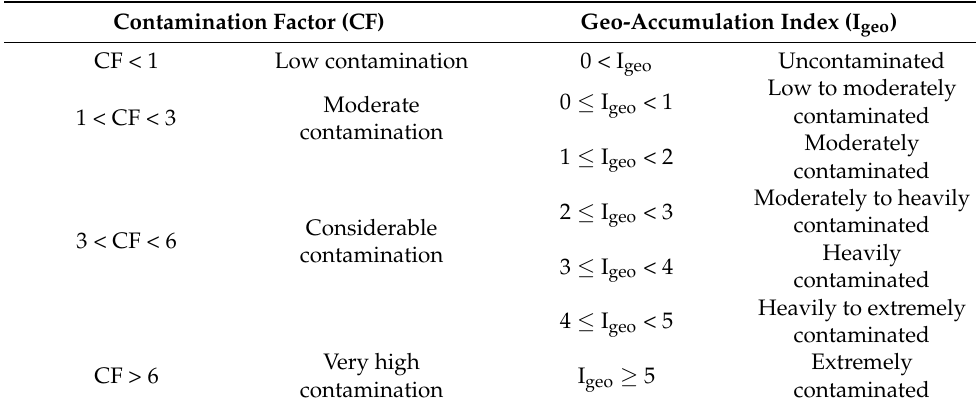
Table 1. Categories of the Contamination Factor (CF) and Geo-accumulation Index (I geo ) according to Mmolawa et al. [25] and Barbieri et al. [26], respectively.